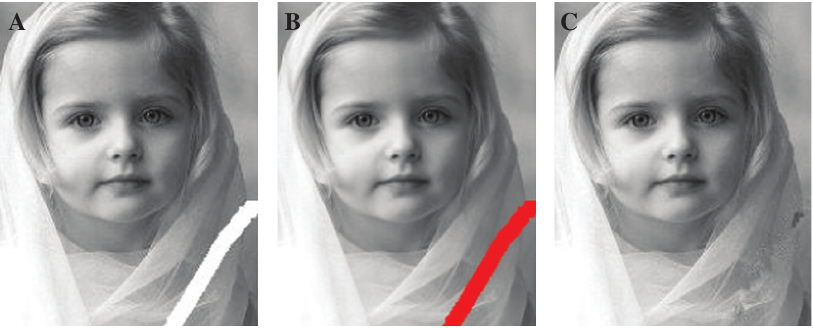
Figure 9. Results with Larger Degradation (Nice3): Patch Size 9 ×